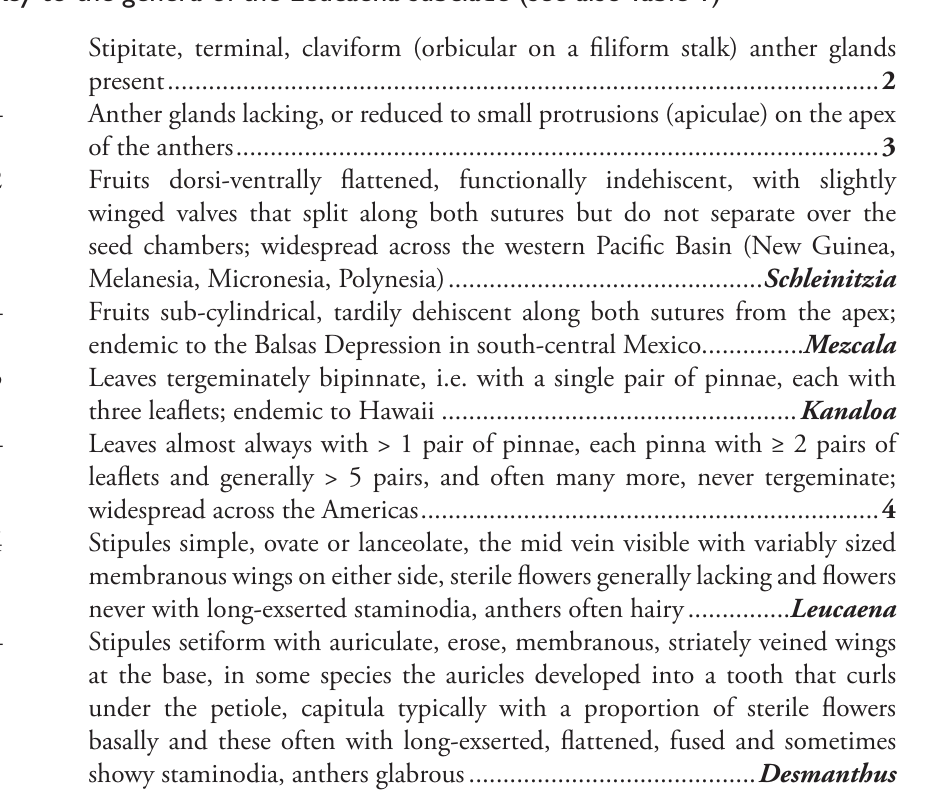
Key to the genera of the Leucaena subclade (see also Table 1) Stipitate, terminal, claviform (orbicular on a filiform stalk) anther glands